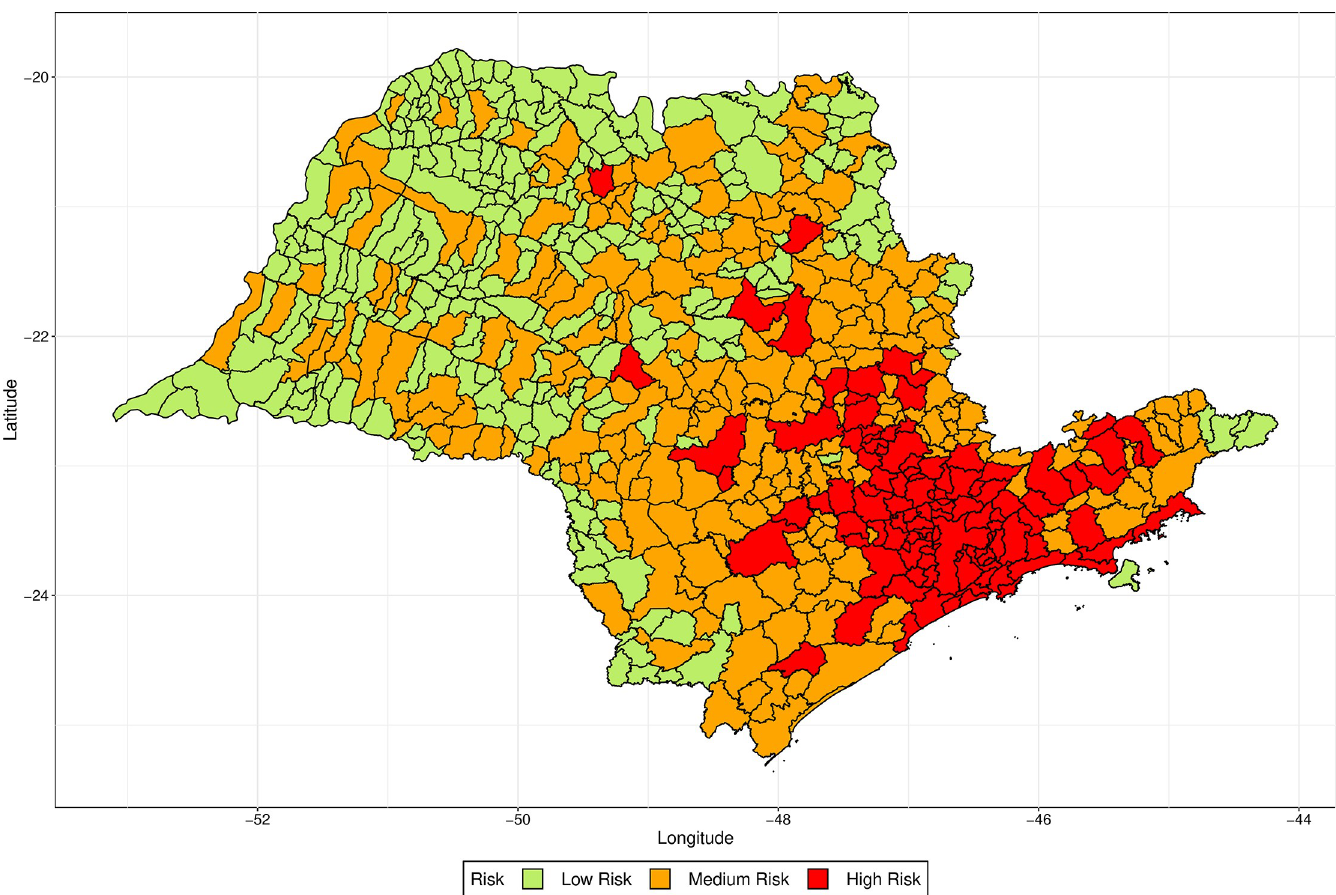
Fig 10. Risk of each city in the state of S ã o Paulo evaluated by k-means clustering of the ranks attributed by the simulated models with distinct values of s .